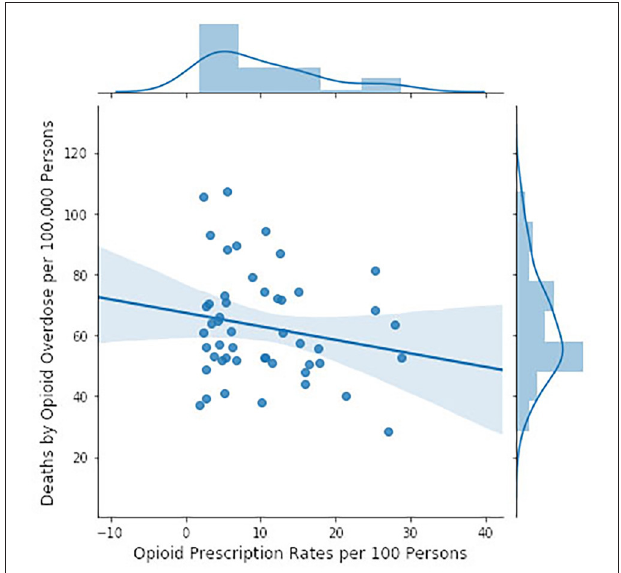
FIGURE 4 | Opioid mortality rates by state in 2016 (111) in relation to number of opioid prescriptions by state ( 110) (CDC data). Opioid mortality rates are based on ICD codes for narcotic related (T40.0–T40.6) intentional and unintentional drug overdose deaths (X42, X62). Opioid prescriptions accounted for 1.5% of the variance in opioid mortality. The slope of the regression line is not significantly different from zero ( F = 1.744, p = 0.193).